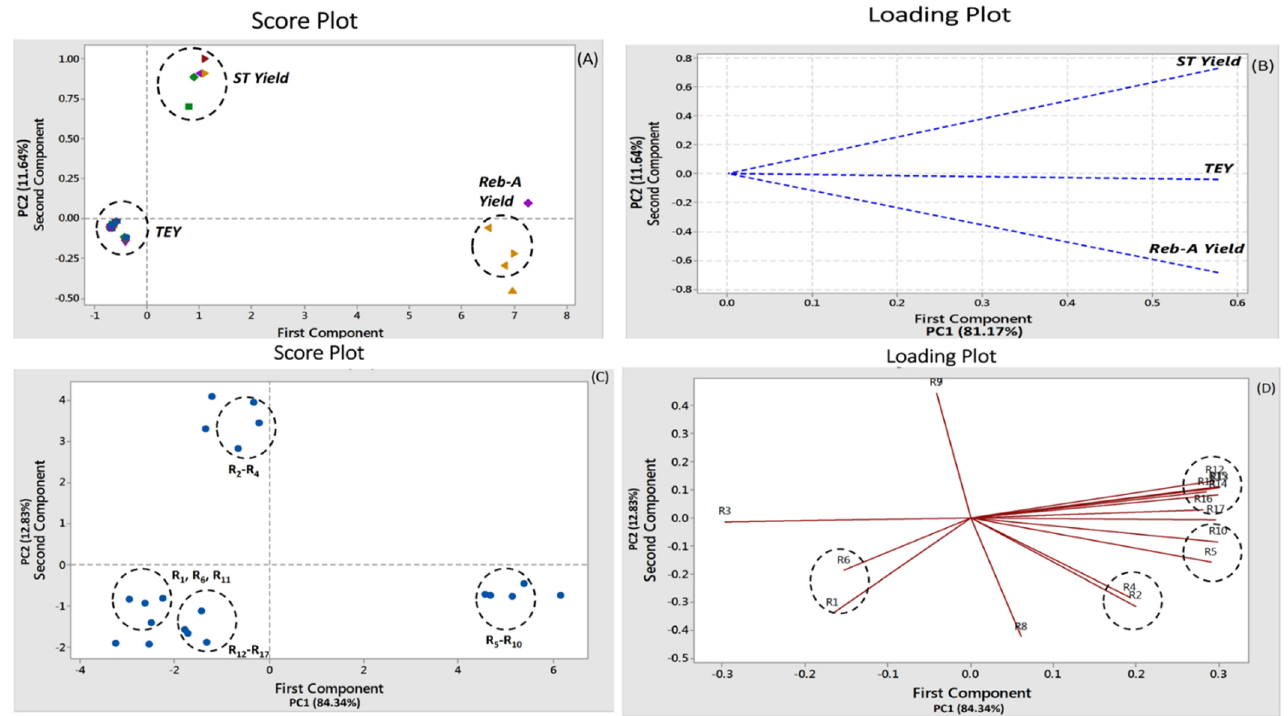
Figure 6. PCA score and loading plots by different target responses ( A , B ) and the extraction condi- tions ( C , D ). The circled clusters showed successful discrimination in terms of target responses and number of experimental runs. Different color in the PCA score plots clusters exhibited peculiarity for each target response analyzed.